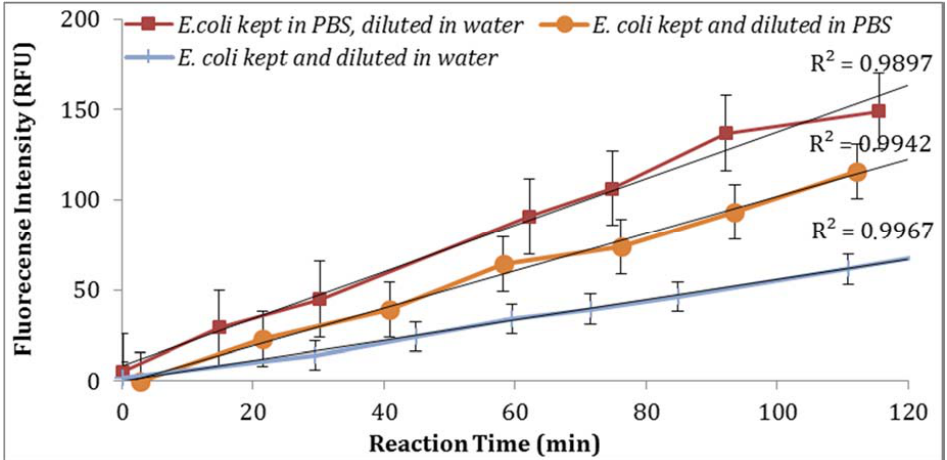
Figure 6. Effect of storage condition of E. coli on GUD